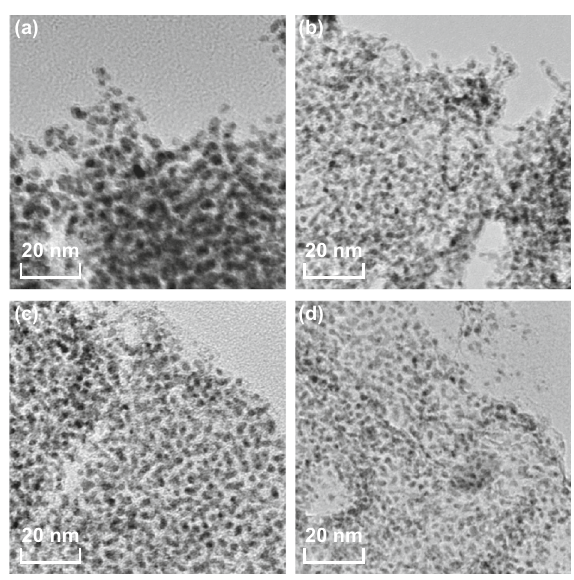
Fig. 3 TEM images of a WCC-2, b WCC-4, c WCC-6, and d WCC-